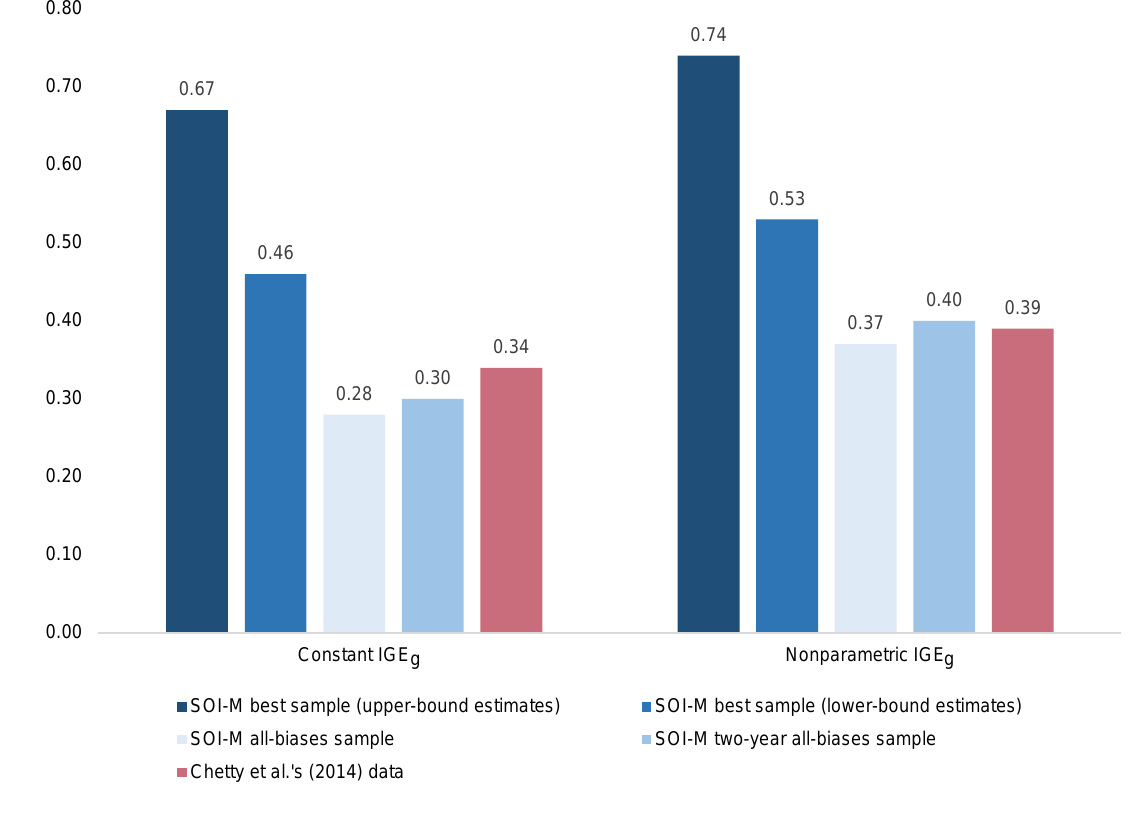
Figure 6: Estimates of the IGE of the geometric mean based on the SOI-M best sample, the SOI-M all-biases samples, and Chetty et al.’s (2014)